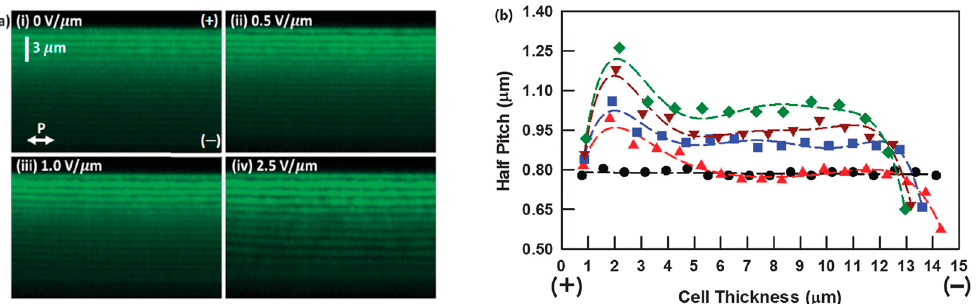
Figure 16. Polarizing confocal microphotographs of the polymer-stabilized cholesteric liquid crystal in the absence and presence of a DC electrical field. ( a ) 0 V µm − 1 and ( b ) 1.1 V µm − 1 . The dashed lines are a guide to the eye. Adapted from ref. [41].